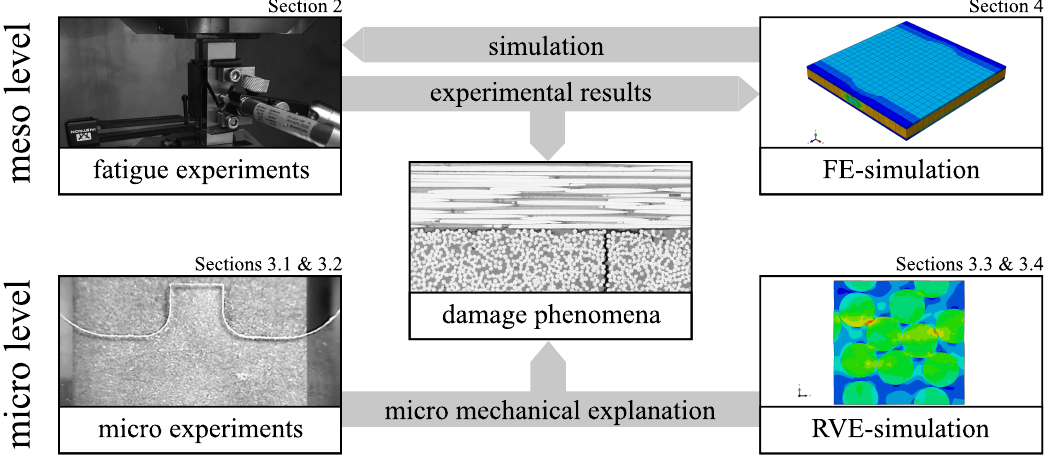
Figure 1. Overall structure of the paper and connections between the individual